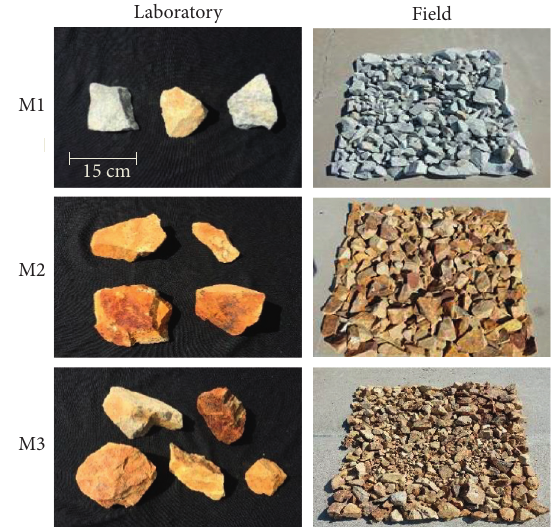
Figure 1: Photos of selected pieces from each rock type were measured in laboratory (a) and the rocks arrangement were measured in the field (b) with an area of 1 squared